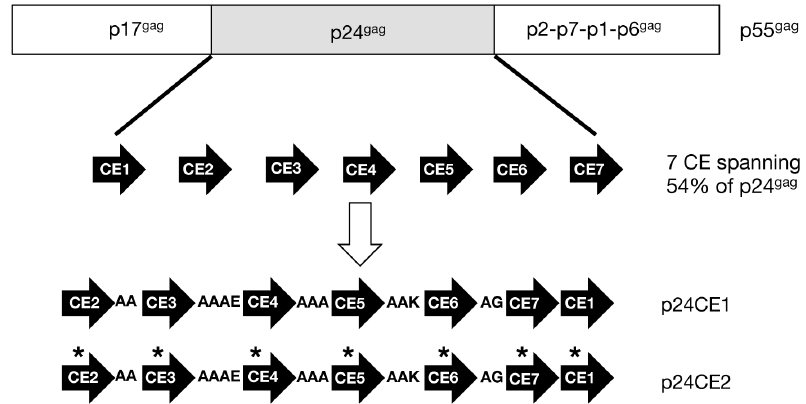
Figure 1. p24CE Expression plasmids. Cartoon depicting the HIV p55 gag protein and its proteolytic cleavage products p17 gag , p24 gag and the C- terminal p2, p7, p1 and p6 proteins. The 7 highly conserved elements (CE) identified within p24 Gag are indicated. The two p24CE constructs differ by 1 ‘toggle’ AA per CE, indicated by asterisks. The 7 CE were connected via linkers and the p24CE proteins were expressed from the CMV promoter using the mammalian expression vector pCMV.kan [18].